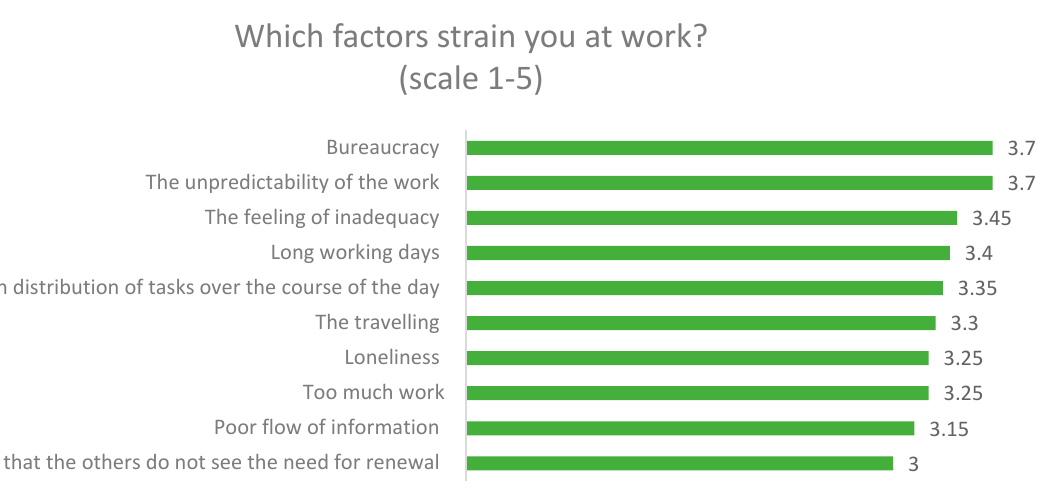
Figure 5. Which factors strain you at work?